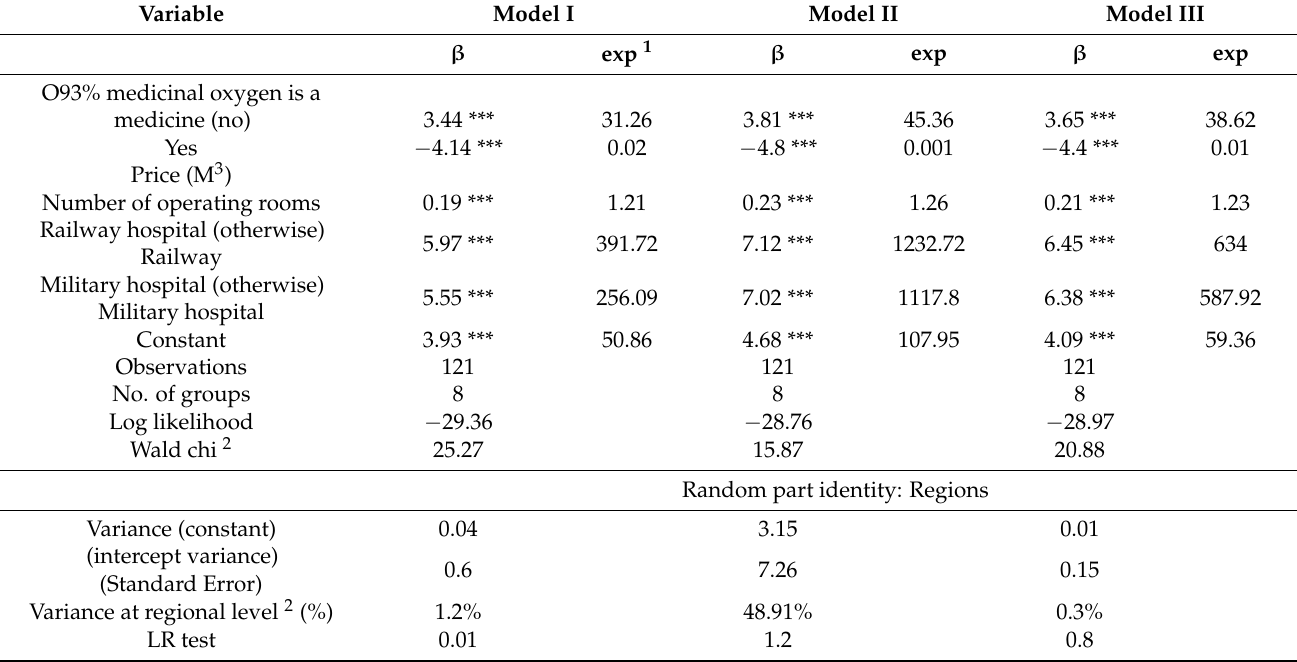
Table 1. Multilevel logistic regression on O93% medicinal